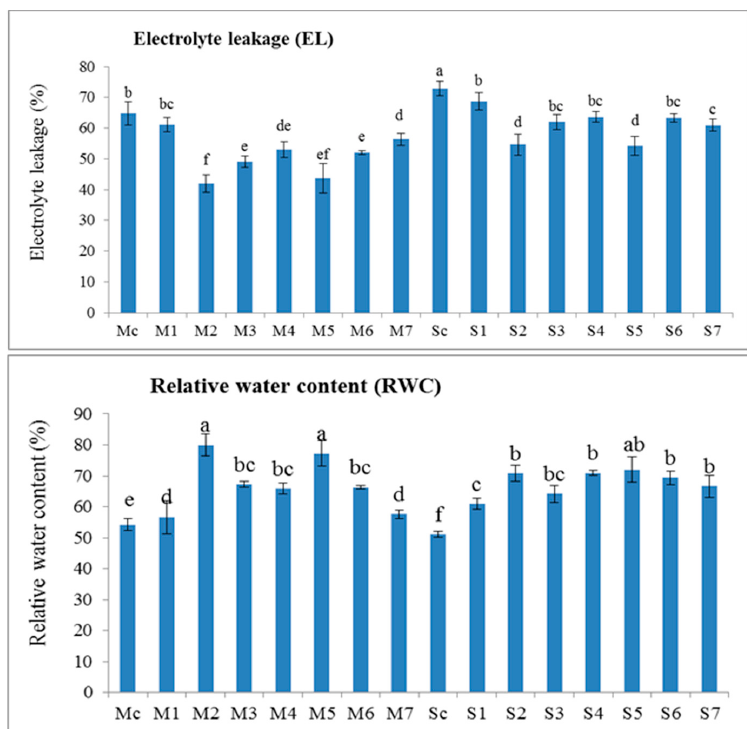
Figure 1. Electrolyte leakage and relative water content in leaves of the two varieties (Misr3 and Sakha3) faba bean plants under infestation with broomrape and treated with different treatments compared with control plants (infested untreated plants) during the second season (2018/2019). Bars indicate standard errors, means with the same letter over the bar are not significantly different according to Duncan’s test at 0.05 probability level. Treatment codes are as follows: M = Misr3 faba bean cultivar (tolerant to broomrape parasitism), S = Sakha3 faba bean cultivar (sensitive to broomrape parasitism C -Control (without treatments), 1-Spraying with 10% solution of SMSE, 2-Spraying + soil amendment with 10% solution of SMSE, 3-Soil amendment with 10% solution of SMSE, 4-Spraying with 10% solution of MCF, 5-Spraying + soil amendment with 10% MCF, 6-Soil amendment with 10% MCF, 7-Spraying with Roundup (144 cm3 ha − 1 ).